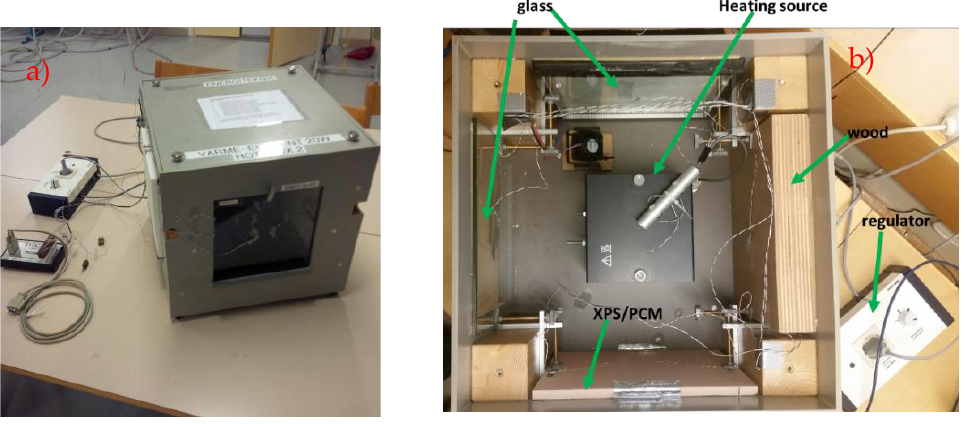
Figure 4. Experimental setup of the hotbox, ( a ) covered by all sides; ( b ) top cover